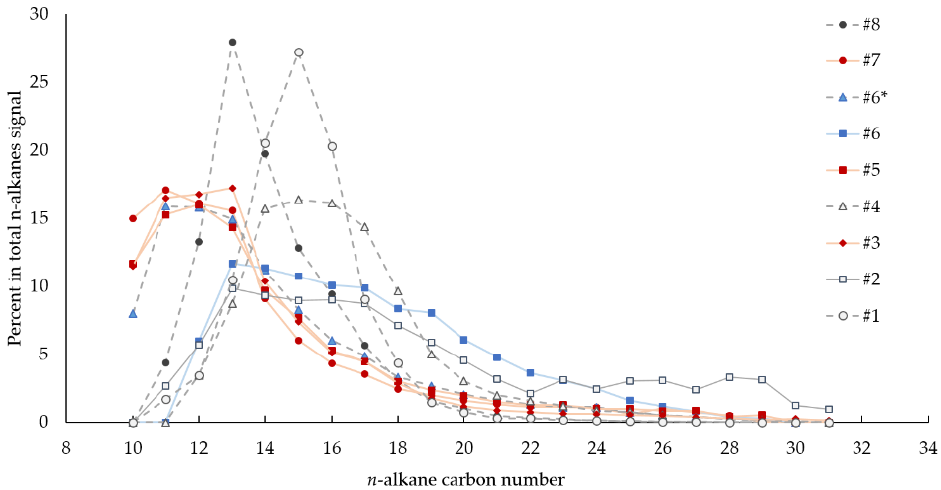
Figure 8. n- Alkanes distribution for thermal extracts of the rocks from the members #1 to #8 (thermal extraction at 350 °C).